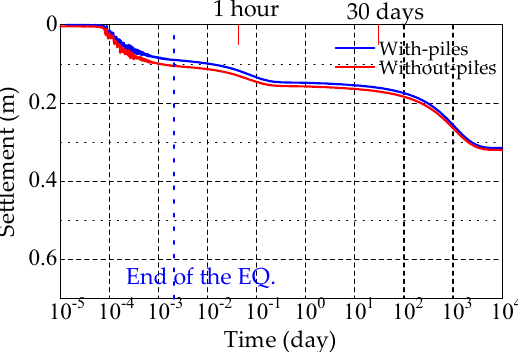
Figure 22. Comparison of settlement behavior during and after earthquake between with and without piles: seismic motion (B).